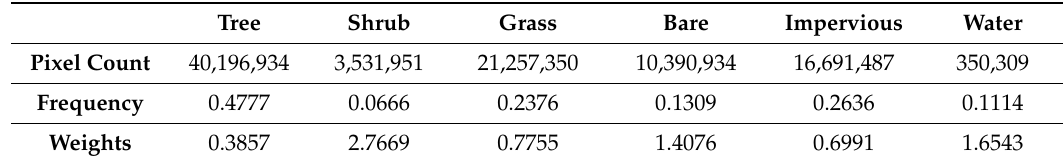
Table 12. Pixel numbers for each class and the computed median frequency class weights used in DeepLabV3 + training (Oregon—6 classes).